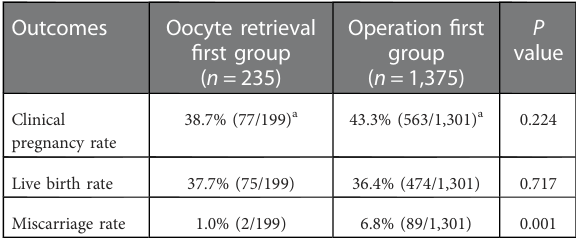
TABLE 2 Pregnancy outcomes of fi rst-time embryo transfer among oocyte retrieval fi rst group and operation fi rst group. Outcomes